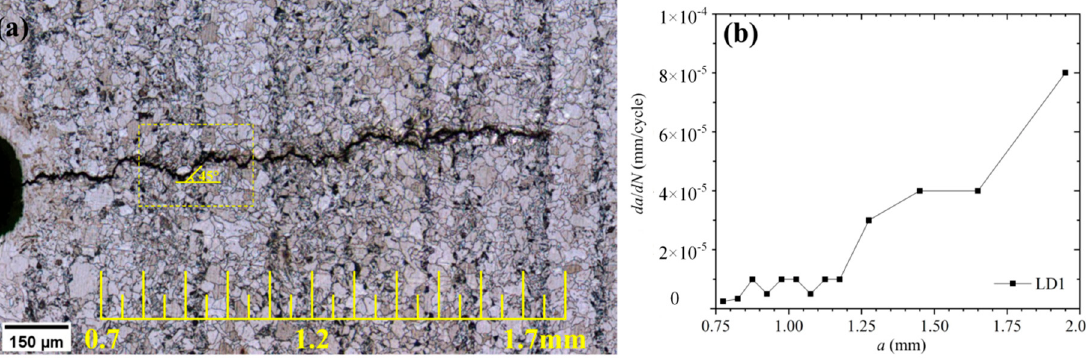
Figure 4. ( a ) The crack growth path of the LD1 specimen; ( b ) da / dN-a curve of the LD1 specimen.